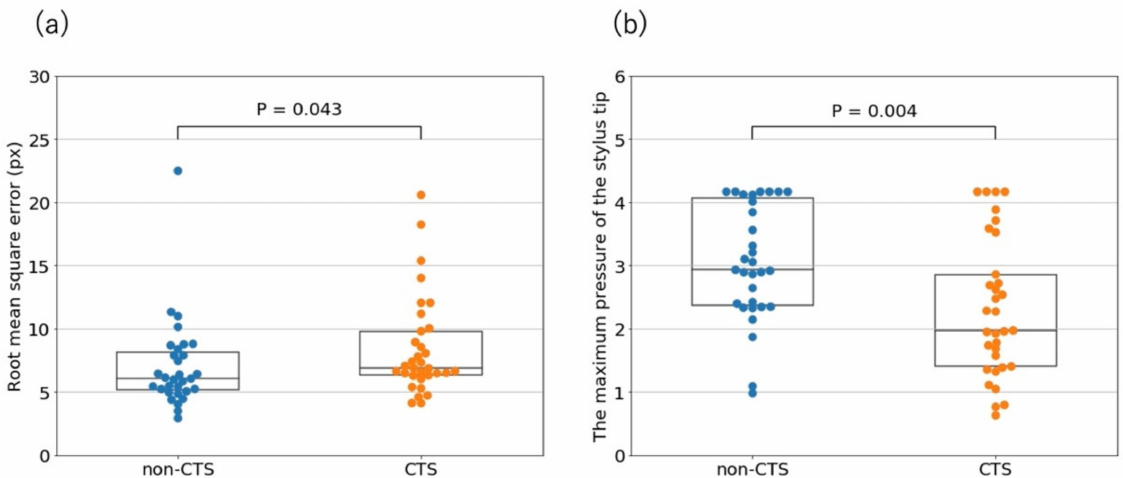
Figure 5. ( a ) Comparison of root mean square errors between the participants’ spirals and the model spiral in the non-CTS and CTS groups. ( b ) Comparison of the maximum pressures of the stylus tip between the non-CTS and CTS groups. There were significant differences between the non-CTS and CTS groups in each